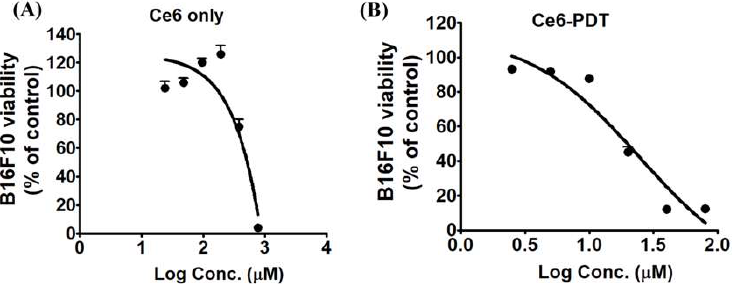
Figure 3. Cytotoxicity of Ce6 PDT to B16F10 cells. Analysis was performed after incubating the cells with 12–768 µΜ and 2.5–100 µΜ of Ce6 for ( A ) dark cytotoxicity and ( B ) photo-induced cytotoxicity.